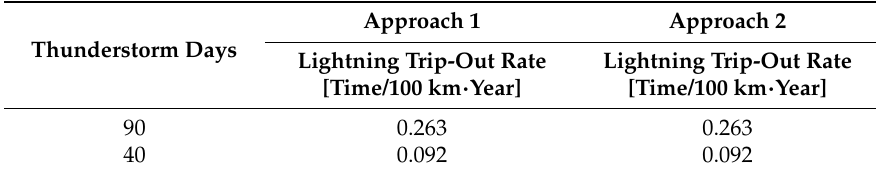
Table 4. Influence of different grounding modes of OPGW on lightning trip-out rate of a UHV AC transmission line.